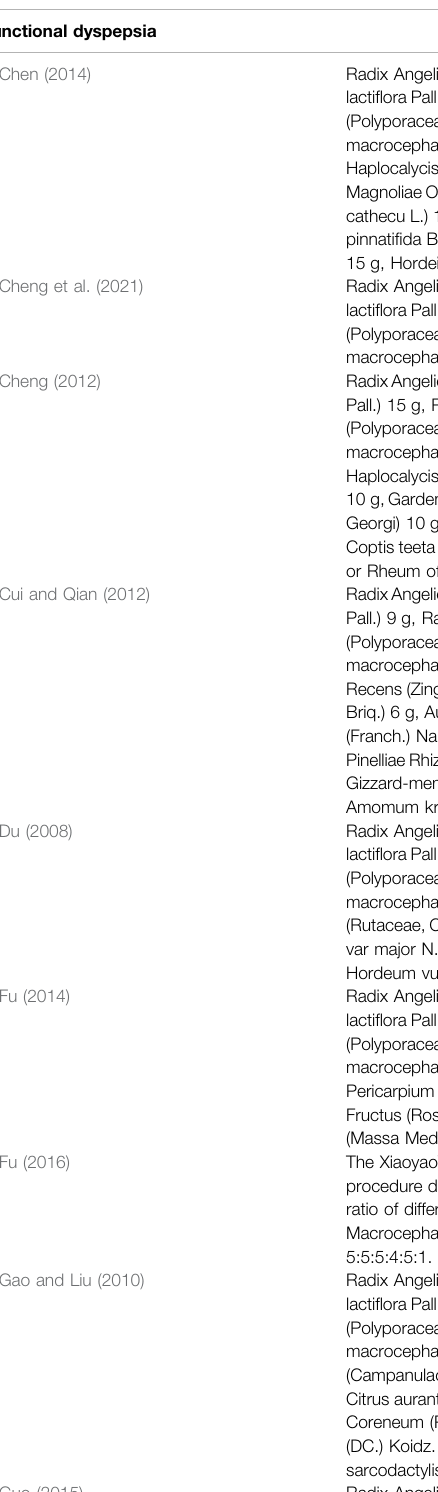
TABLE 2 | The ingredients of Xiao Yao San used in 48 studies. Authors